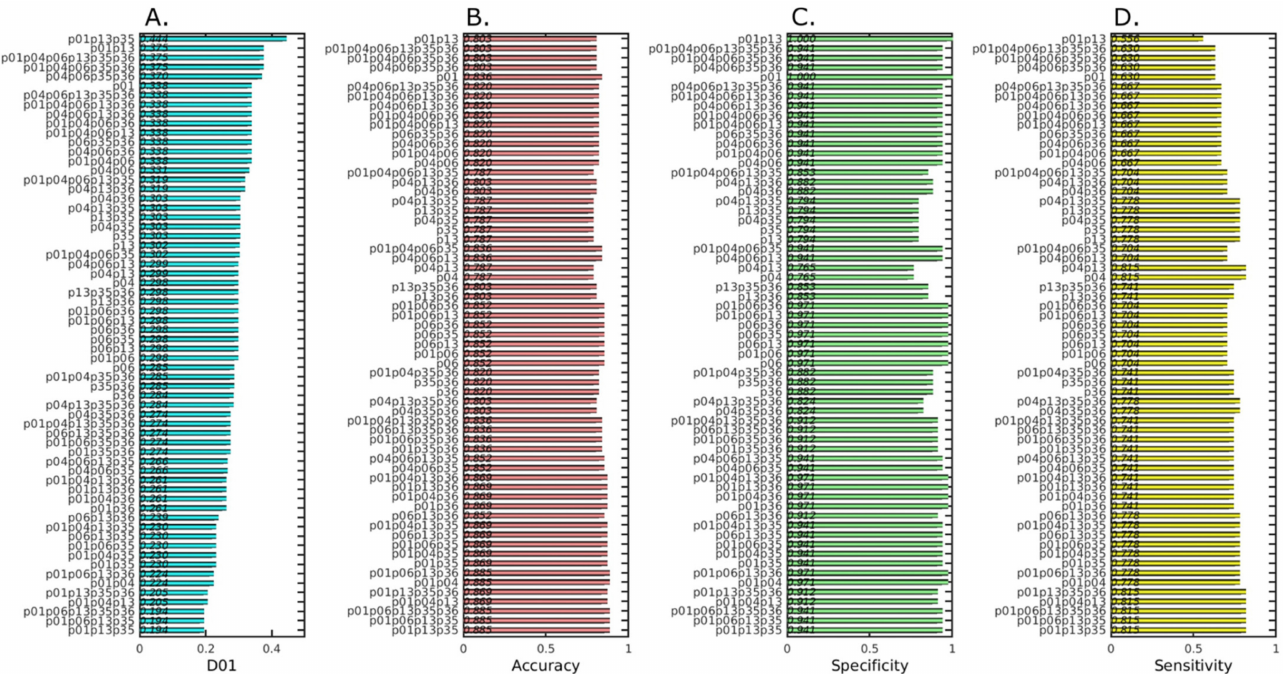
Figure 3. Bar plots of the quality measurements associated with the Receiver Operating Characteristic (ROC) of the performance of the predictions achieved with each of the combinations of predictor variables for the discriminant analysis between Healthy and Tumor on the prospective dataset. ( A ) D01, distance to the optimal point (0, 1) of the ROC space. ( B ) Accuracy. ( C ) Specificity. ( D ) Sensitivity. The bars in all bar plots are sorted in descending distance to the optimal point (0, 1) of the ROC